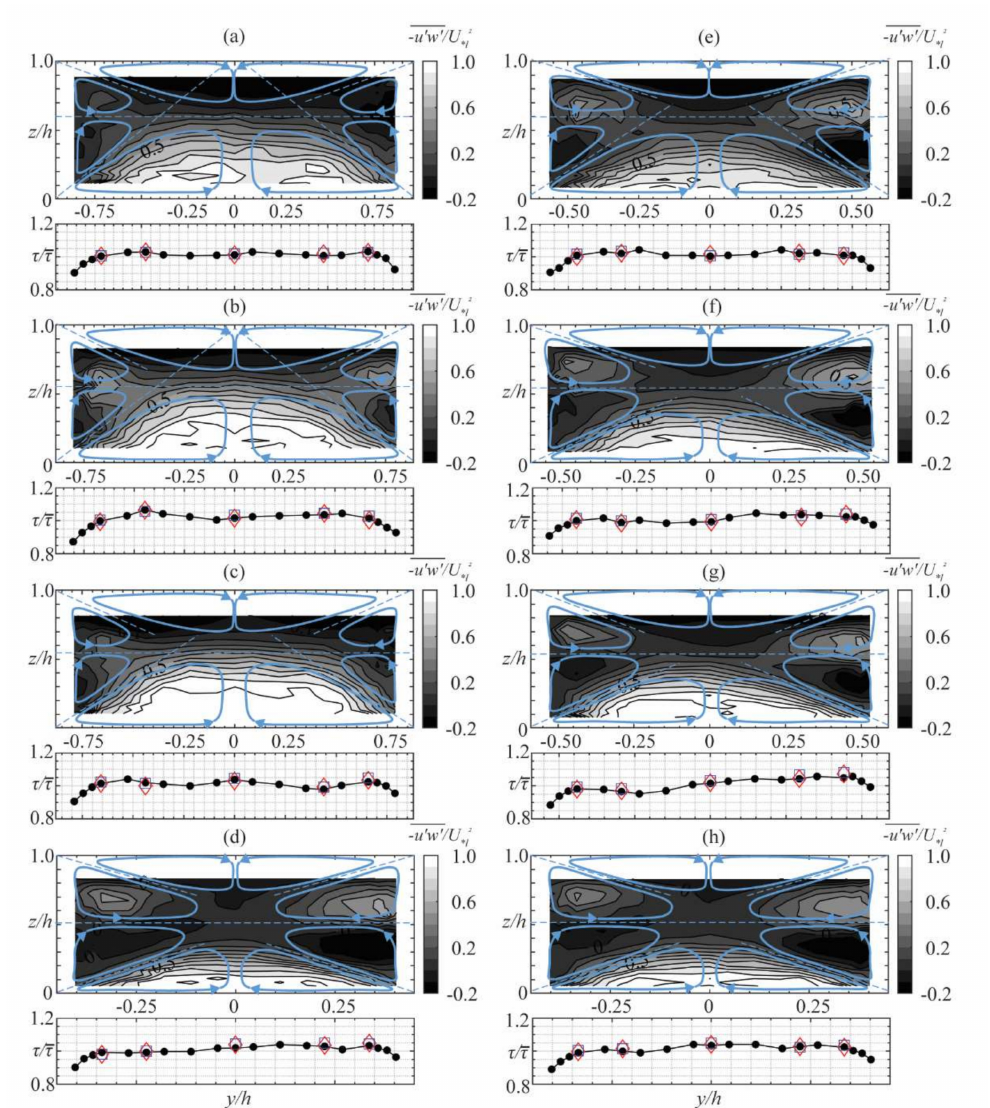
Figure 11. Contour plots of normalized Reynolds shear stresses and normalized bed shear stresses for ( a – c ) TA1–TA3, ( e – g ) TA4–TA6, ( d , h ) TA7 and TA8 (measurements at • : x = 5.40 m; ♦ : x = 5.15 m; (cid:3) : x = 4.90